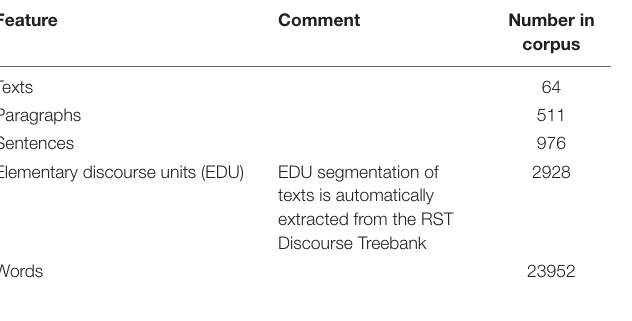
TABLE 1 | The WSJ MoRA 2015 corpus: a quantitative characterization.